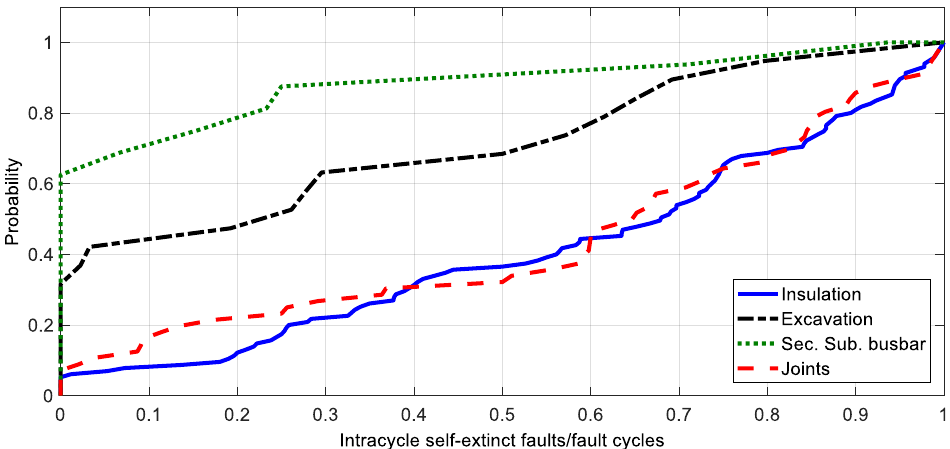
Figure 9. Observed cumulative probability for intra-cycle self-extinct fault cycles’ relation to the total number of fault cycles.